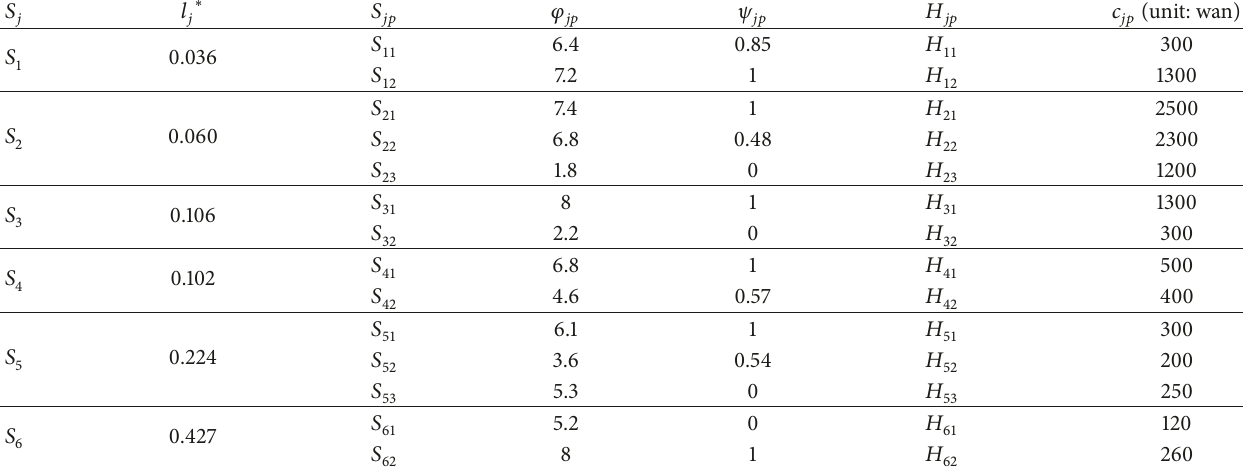
Table 8: Summary of factors related to service elements.